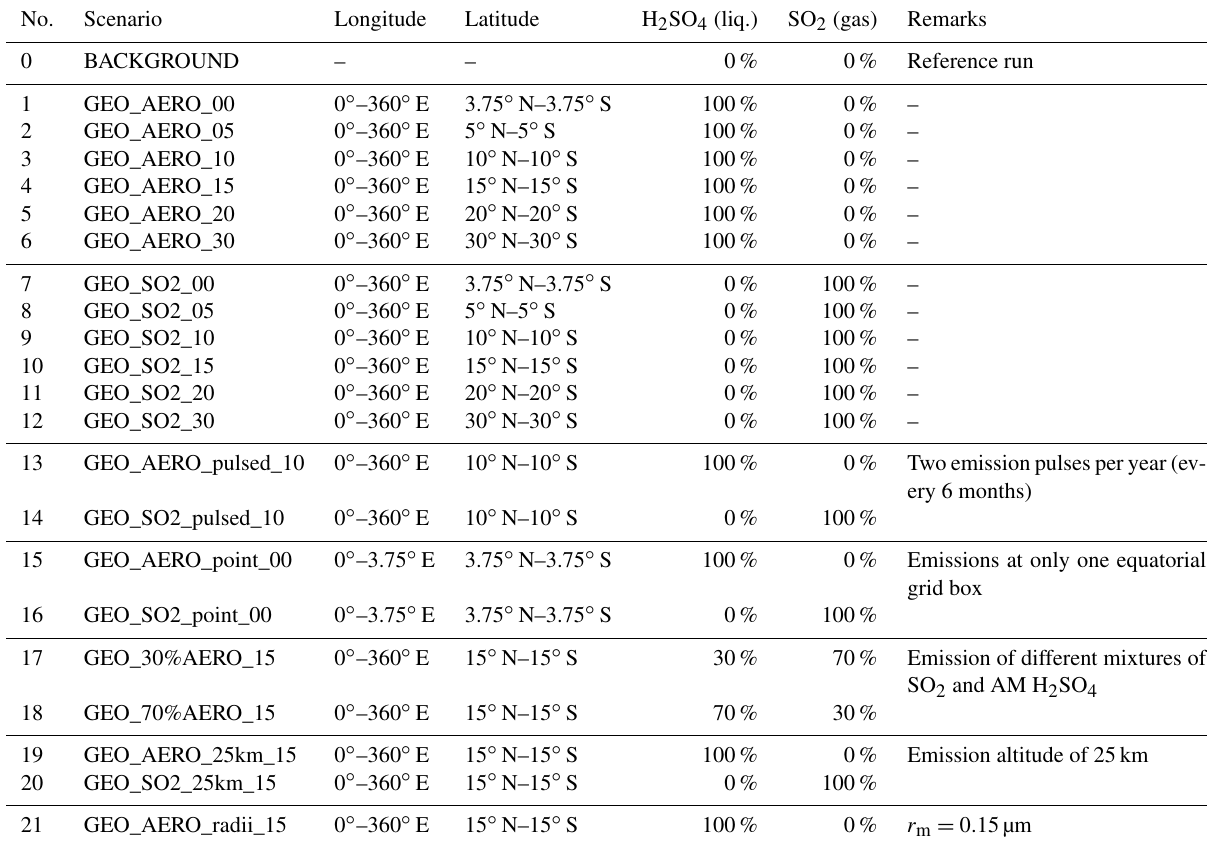
Table 1. Overview of all simulations performed in this study. Each GEO scenario (1–12) assumes a zonally symmetric and continuous injection of 1.83MtSyr − 1 as SO 2 and/or accumulation-mode particles (AM H 2 SO 4 ) with log-normal size distribution (dry mode radius, r m = 0 . 095µm and distribution width σ = 1 . 5). Longitudinal and latitudinal distributions as well as emission ratios of liquid to gas (in sulfur mass) are shown in columns 3–6. GEO scenarios (13–20) deviate from these standard conditions as indicated under